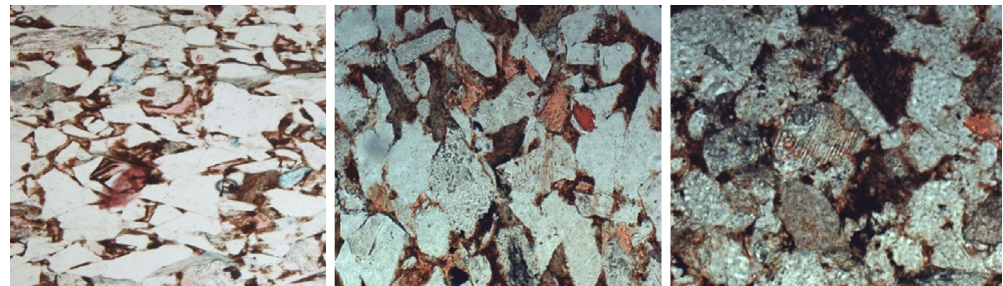
Figure 2: Reservoir space characteristics of di ff erent modal pore throat types. No. 1: wide bimodal mode. The main development of intergranular pore, dissolved pores, and a small number of micropores. No. 3: wide bimodal mode. The main development of dissolution pore and a small amount of intergranular pore and micropores. No. 9: asymmetry bimodal mode. The main development of micropores and a small number of dissolved pores.